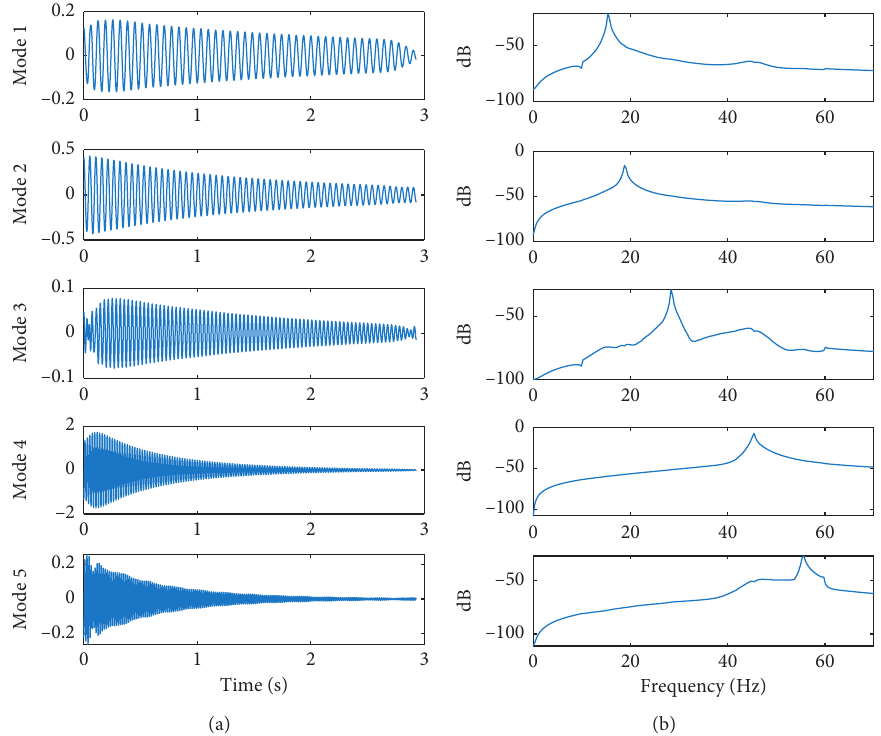
Figure 17: (a) The extracted five modes by the proposed method based on VMD and (b) the corresponding Fourier